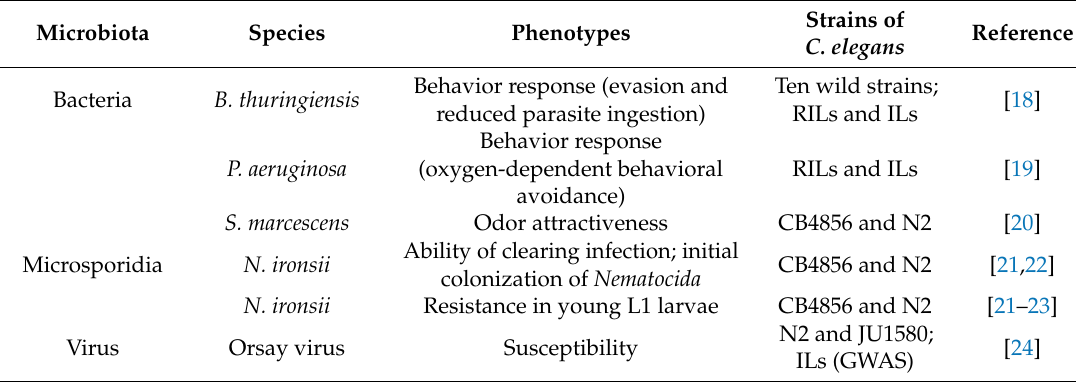
Table 1. Quantitative genetic studies of C. elegans –microbiota